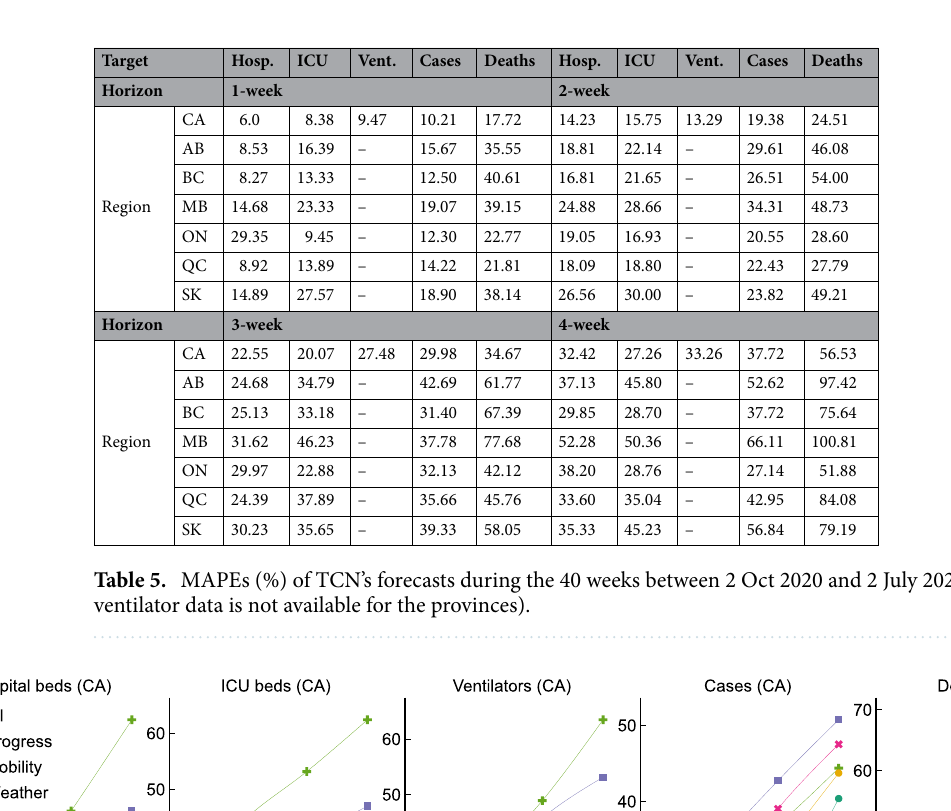
Target Hosp. ICU Vent. Cases Deaths Hosp. ICU